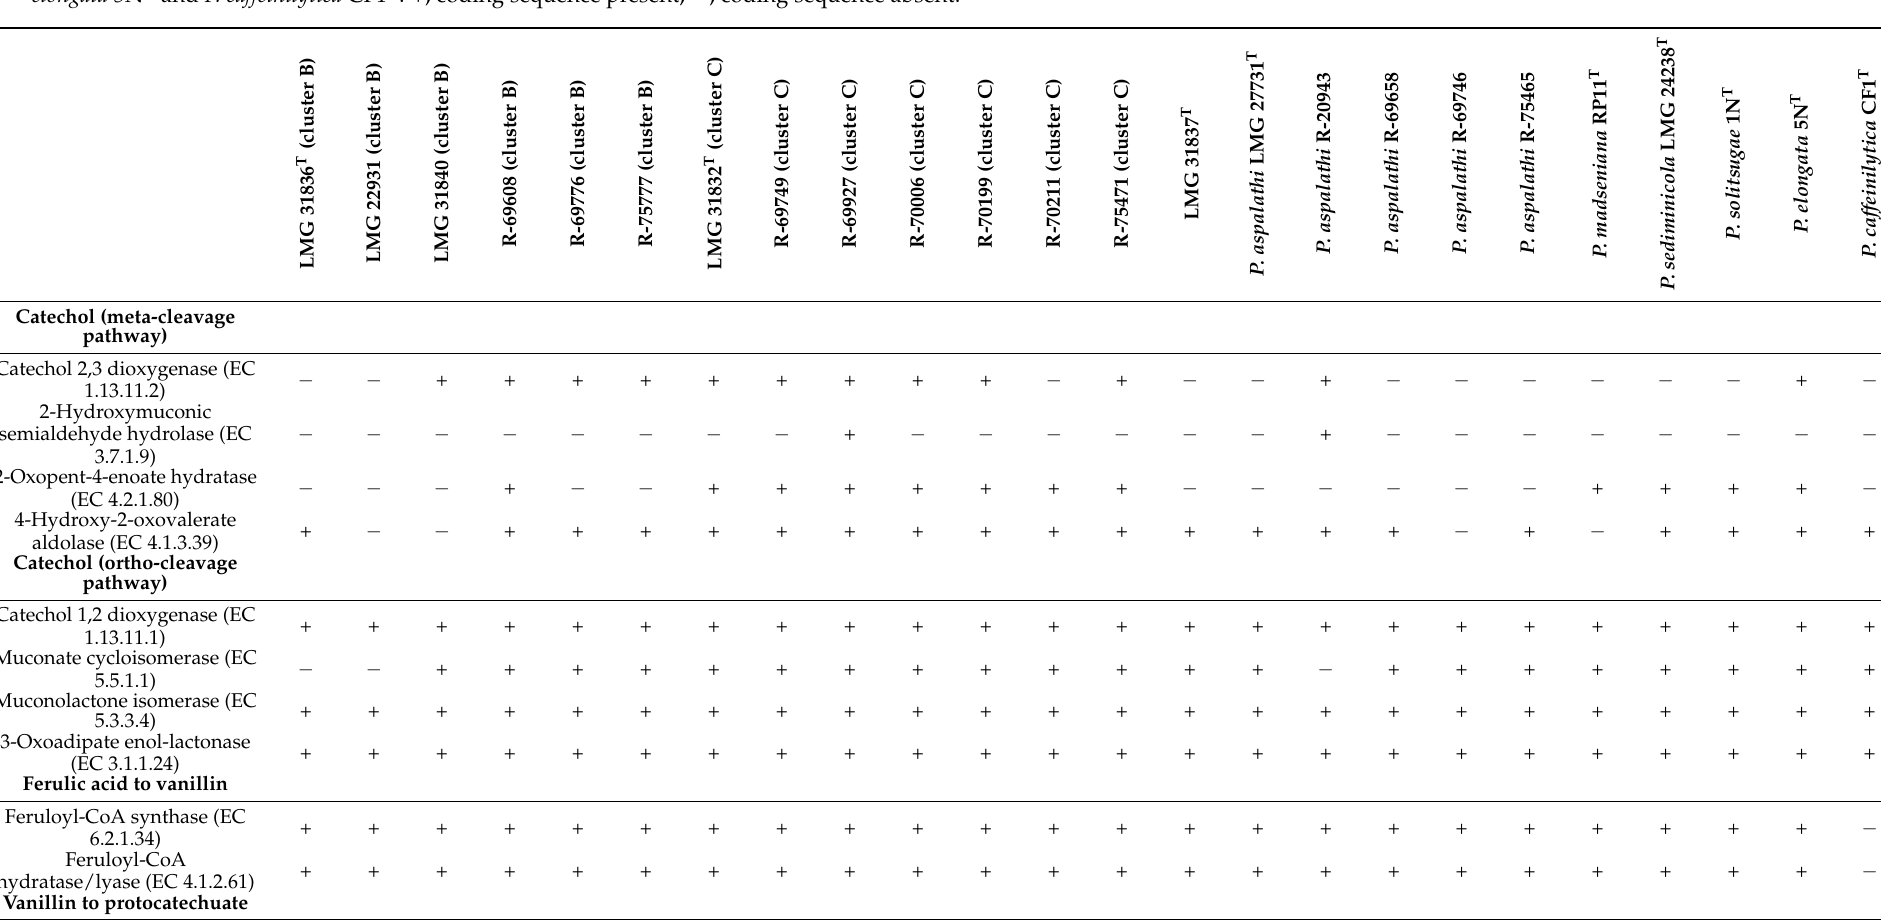
Table 5. Overview of enzymes required for the degradation of benzoic acid, 3-hydroxybenzoic acid, lignin-derived compounds ferulic acid and p-coumaric acid and their degradation intermediates in the draft genomes of the 18 selected isolates and their closest relatives P. aspalathi LMG 27731 T , P. madseniana RP11 T , P. sediminicola LMG 24238 T , P. solitsugae 1N T , P. elongata 5N T and P. caffeinilytica CF1 T . +, coding sequence present; − , coding sequence